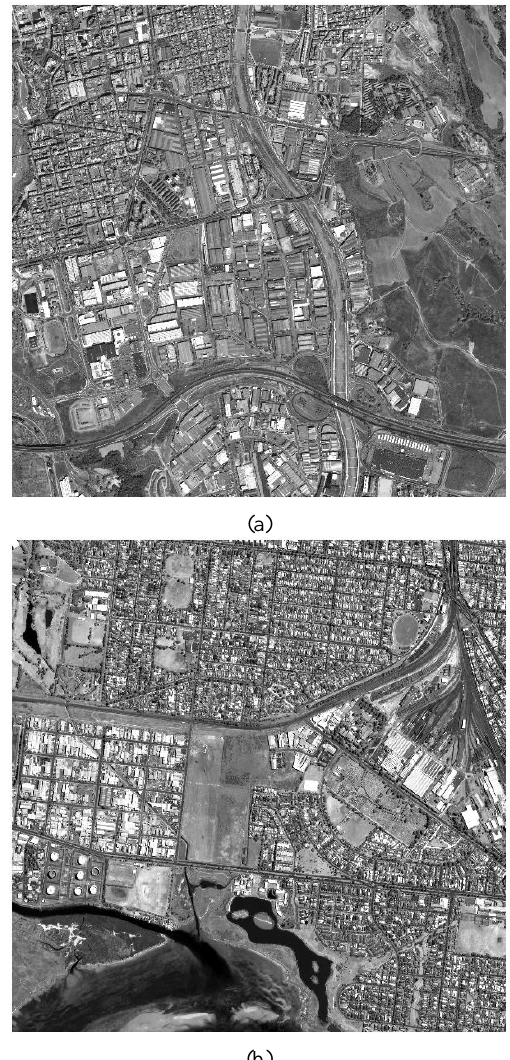
Figure 2. Two stereo pairs used in our experiments.